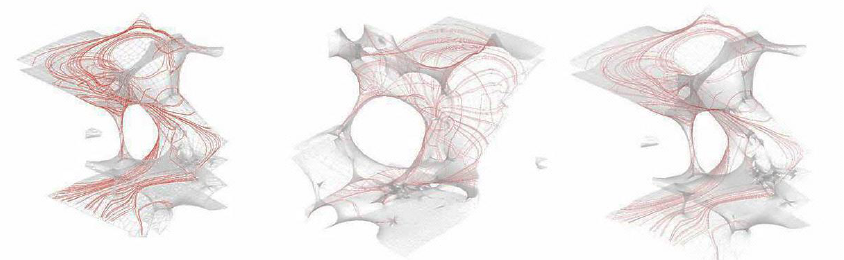
Figure 5. Proto architectural complexes as integrated formal/spatial systems. The result of the lawful interaction of physical forces or organic systems where the shapes are integrated and